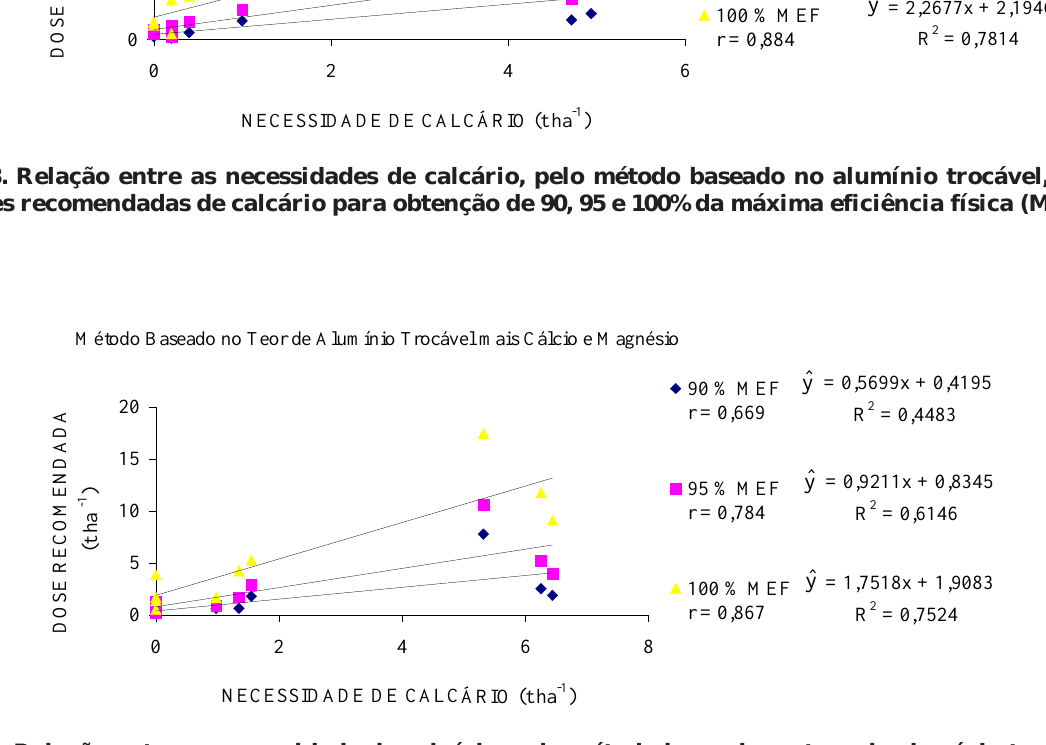
Figura 4. Relação entre as necessidade de calcário, pelo método baseado no teor de alumínio trocável mais cálcio e magnésio, e as doses recomendadas de calcário para obtenção de 90, 95 e 100% da máxima eficiência física